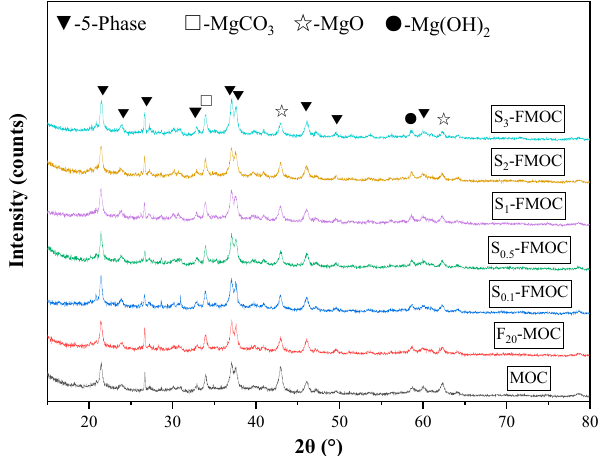
Figure 12. XRD patterns of hardened multi ‐ doped MOC.